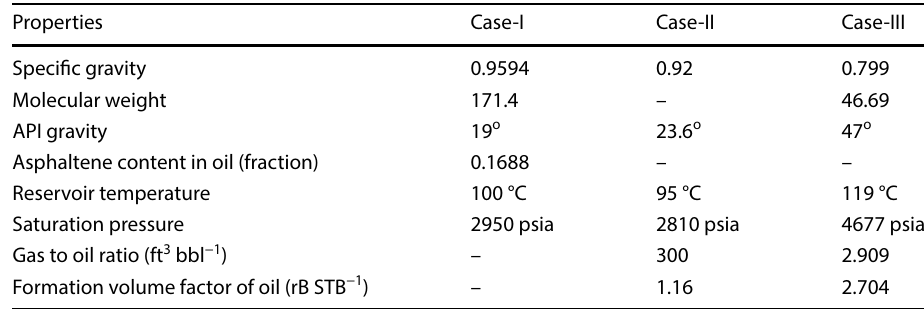
Fig. 2 Amount and oil and water content at varying pro- duction states